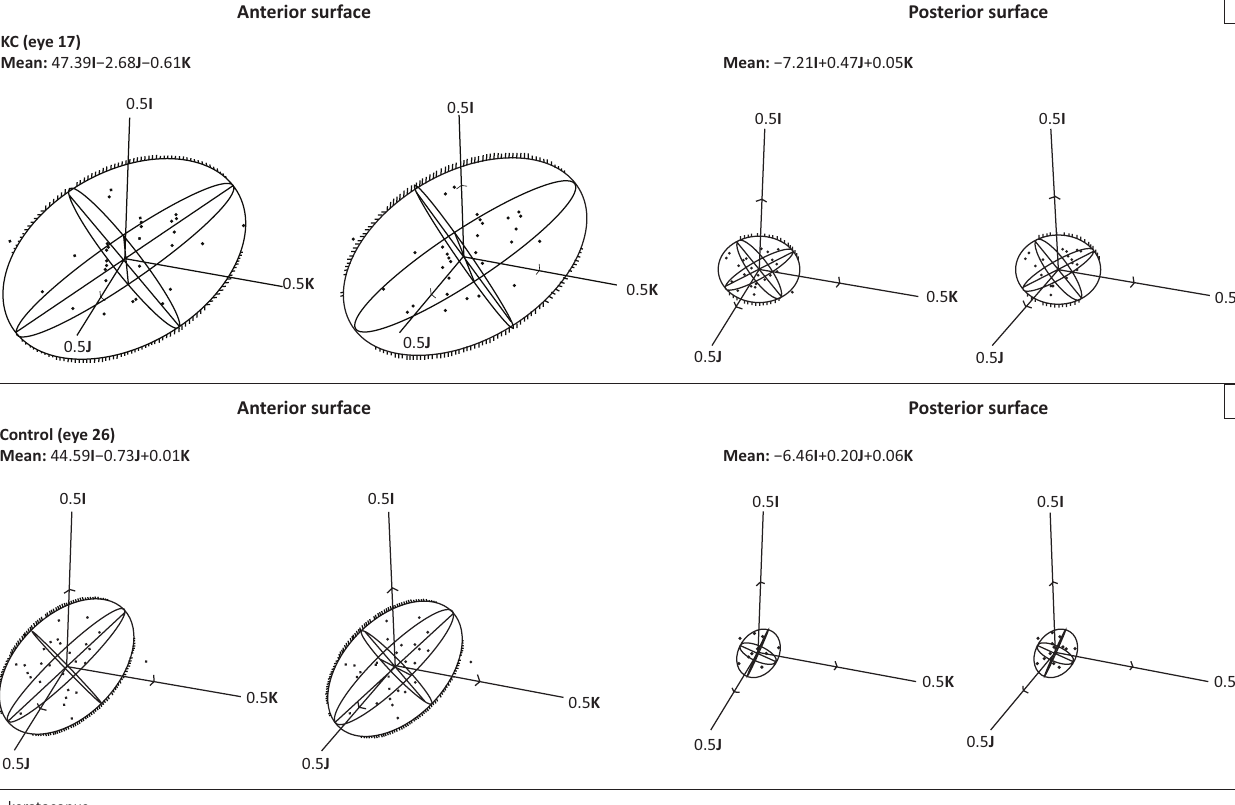
FIGURE 1: Stereo-pair scatter plots with 95 % distribution ellipsoids for one randomly selected eye from the keratoconus group (eye 17) and the other from the control group (eye 26) for anterior and posterior central corneal power. The origin for each stereo-pair is placed at its sample mean as indicated above. Each stereo-pair has an axis length of 0.5 dioptre and a tick interval of 0.25 dioptre. Table 4 to follow includes the variances for these